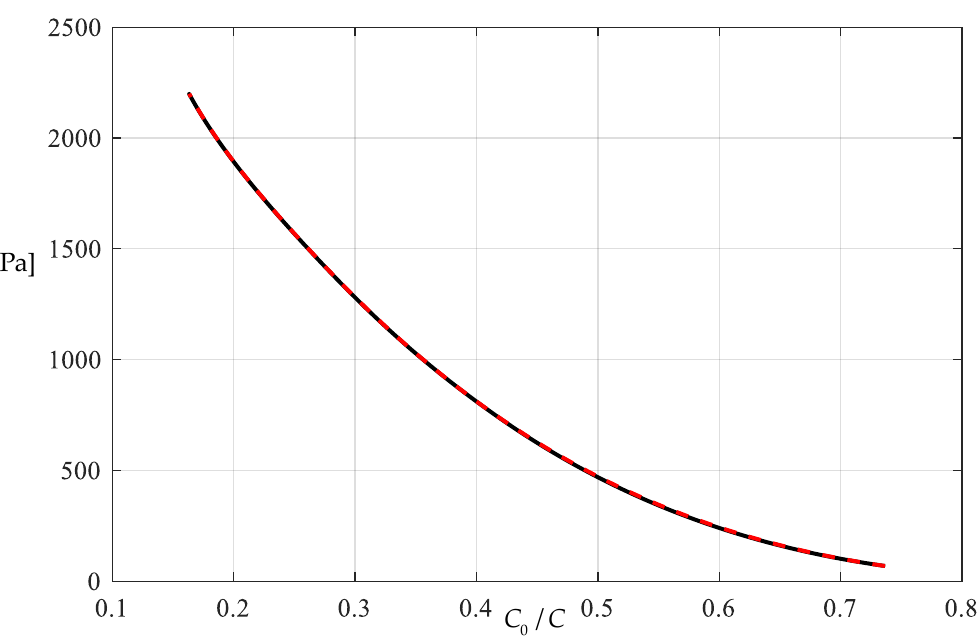
Figure 11. Variations of q with w m .